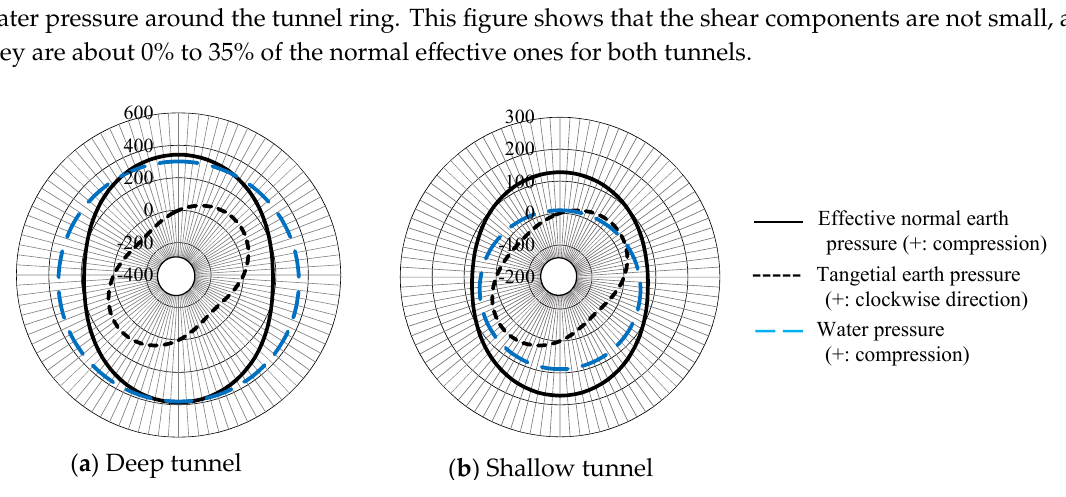
Figure 6. Distribution of initial earth pressure and water pressure on the lining (kN/m 2 ).